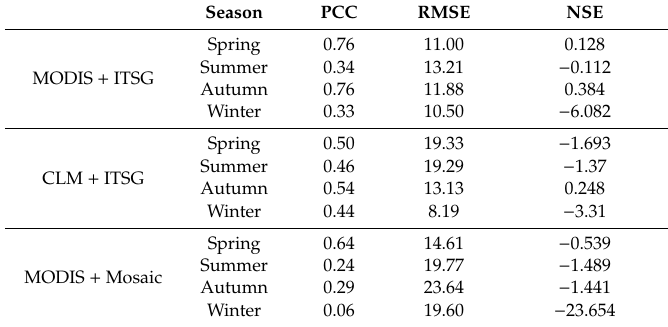
Table 8. Seasonal statistical assessment of the remotely sensed runo ff derived from the comparison between the MODIS evapotranspiration and ITSG GRACE terrestrial water storage (MODIS + ITSG), CLM evapotranspiration and ITSG GRACE terrestrial water storage (CLM + ITSG), and MODIS evapotranspiration and Mosaic terrestrial water storage (MODIS + Mosaic), and the ground-based observed runo ff data registered at the Datong